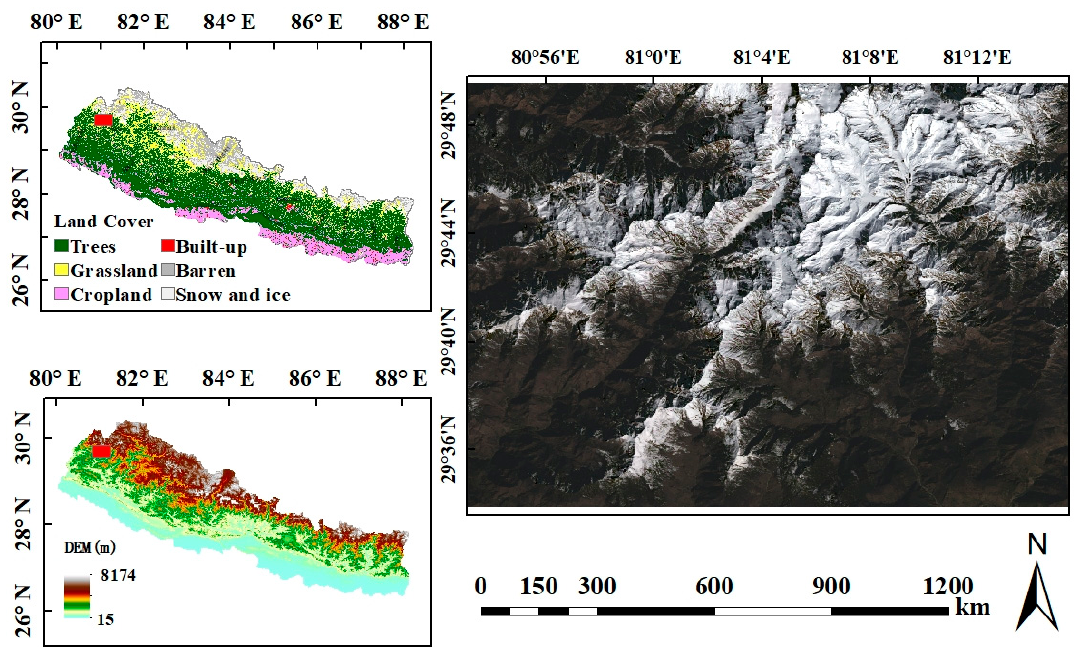
Figure 1. The location map of the study area. The top left image shows the land cover types of Nepal. The bottom left image shows the DEM of Nepal. The right image shows the RGB composites of the Landsat surface reflectance image on 12 February 2020.